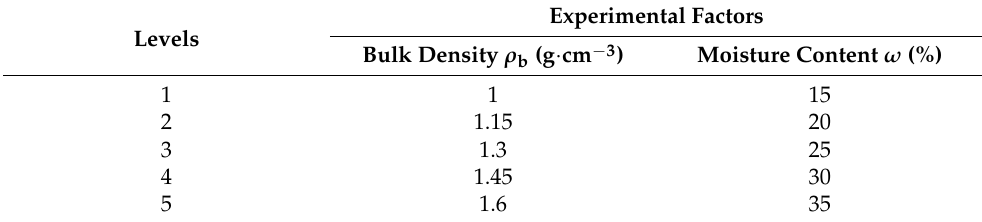
Table 3. Experimental factors and